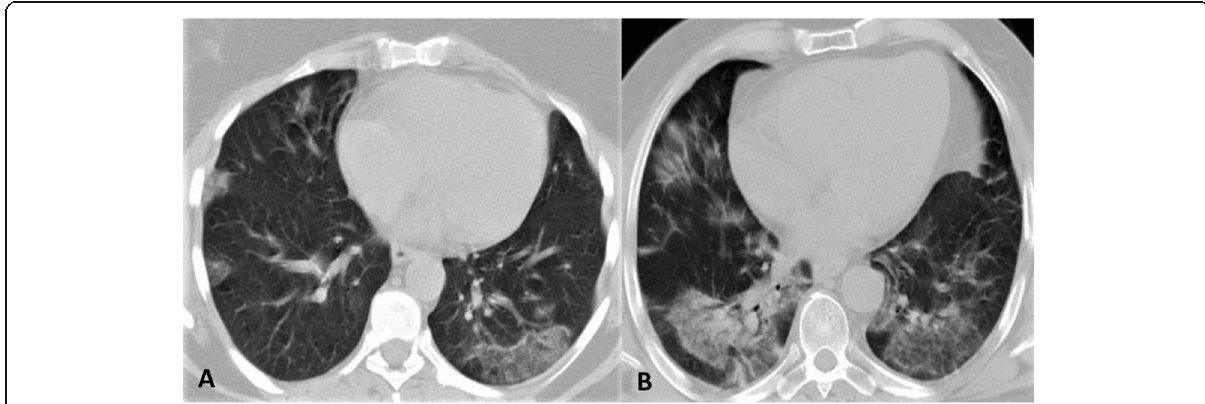
Fig. 3 CT images of asymptomatic patients. a Axial CT image of a 50-year-old RT-PCR (+) asymptomatic female patient shows bilateral peripheral ground glass areas. b Axial CT image of a 52-year-old RT-PCR ( − ) asymptomatic male patient shows bilateral peripheral ground glass